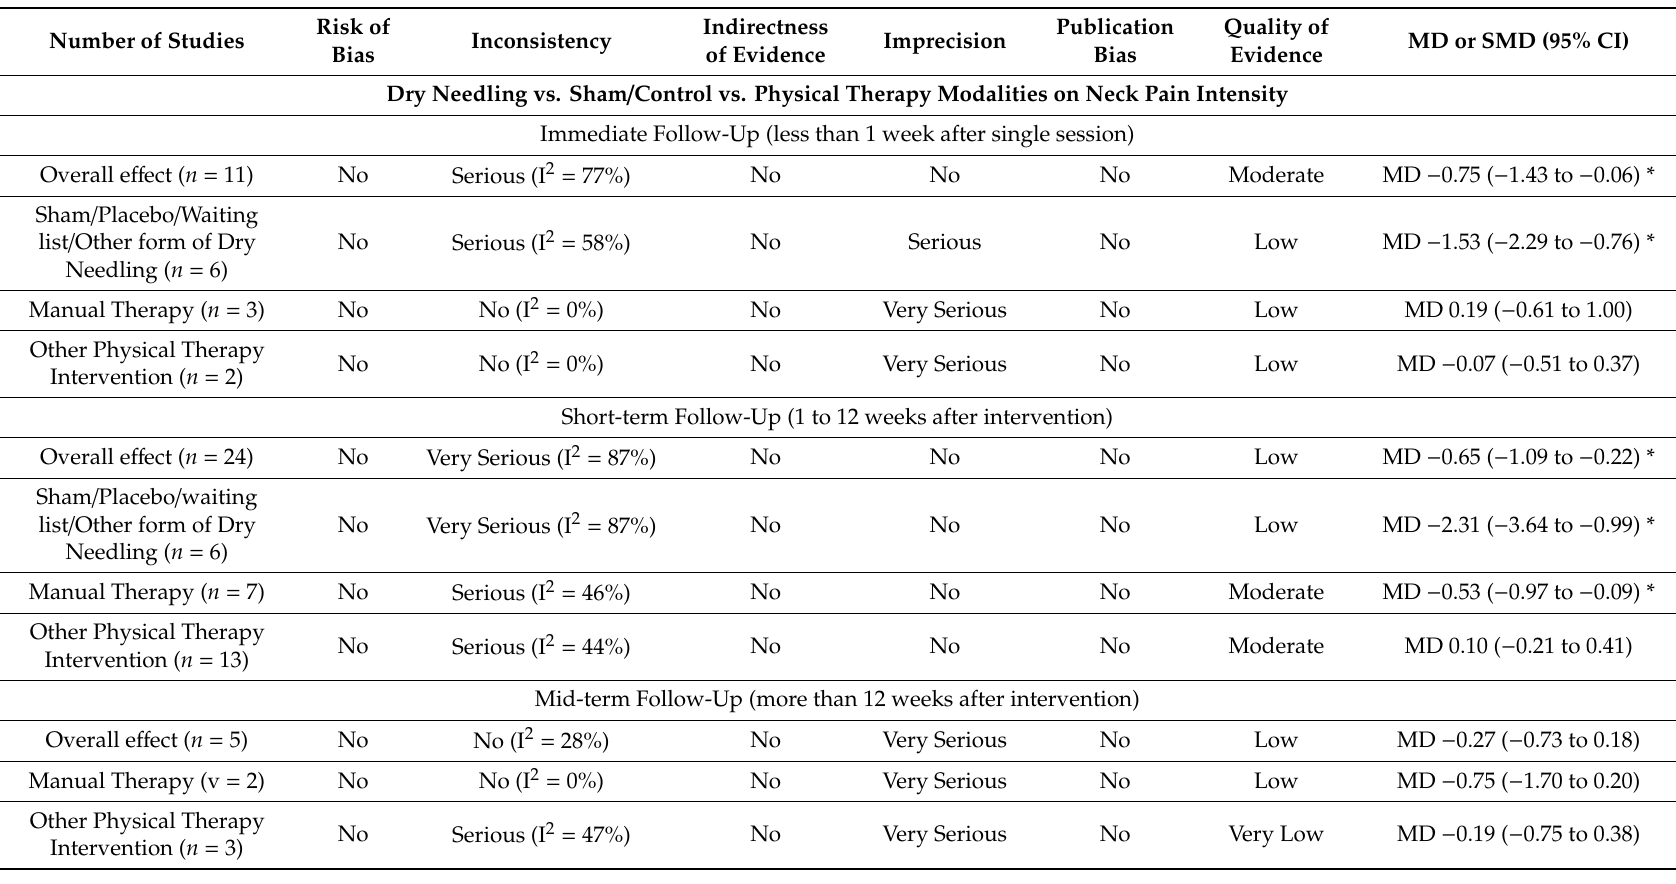
Table 6. Level of Evidence (Grading of Recommendations Assessment, Development, and Evaluation (GRADE)) for dry needling on pain intensity, pressure pain sensitivity, and cervical range of motion in patients with neck